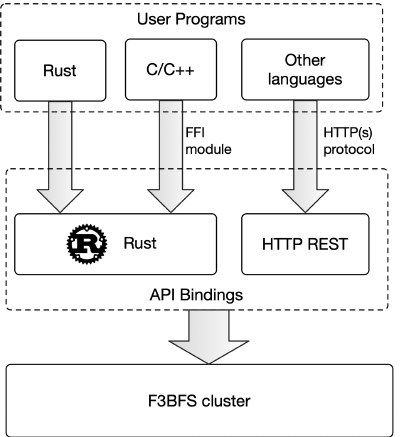
Figure 3. API bindings provided by